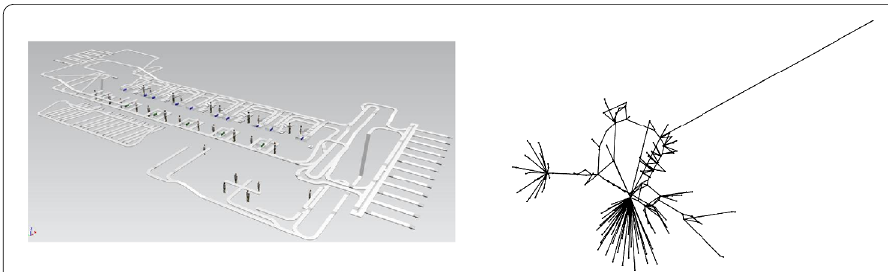
Figure 16 Stress majorization applied to the initial layout computed by CMDS